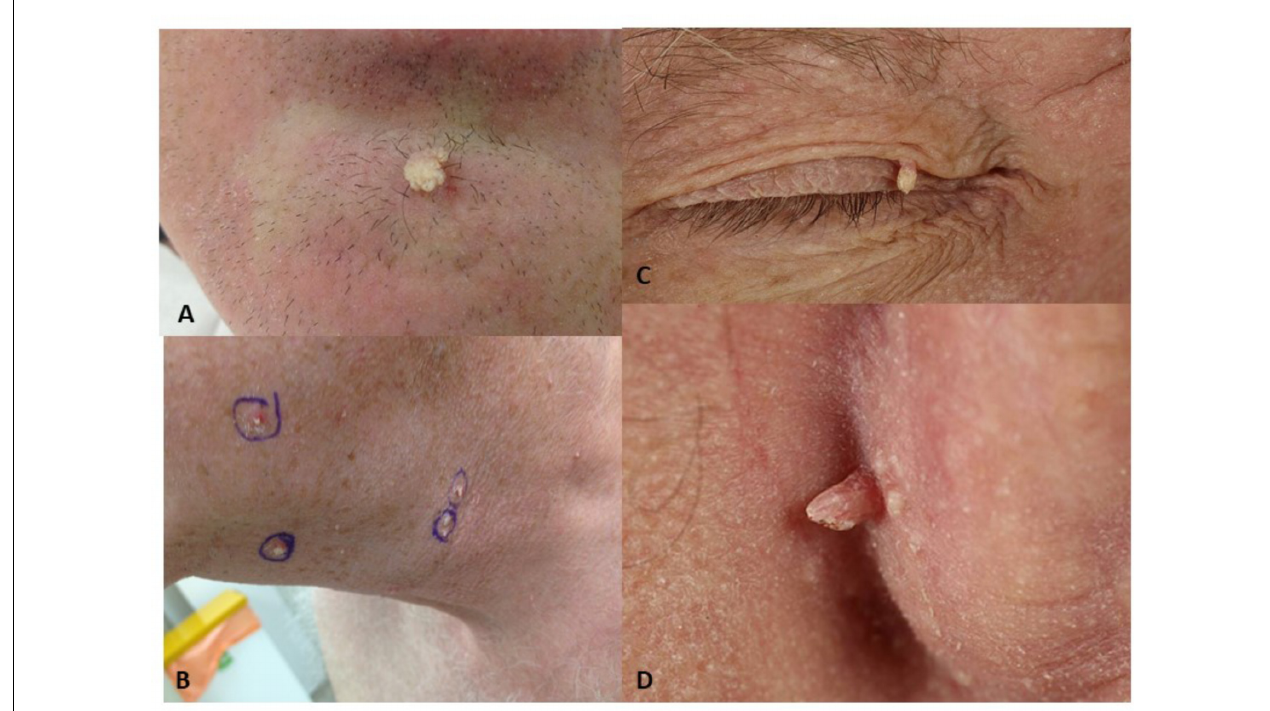
FIGURE 1 | Viral-wart like lesions developing after BRAFi exposure. (A) Lesion V10, viral wart on chin of patient 2; (B) Viral warts on the neck and chin of patient 1; (C) Viral wart on the eyelid of patient 5; (D) Lesion V22, post-auricular viral wart in patient 3.